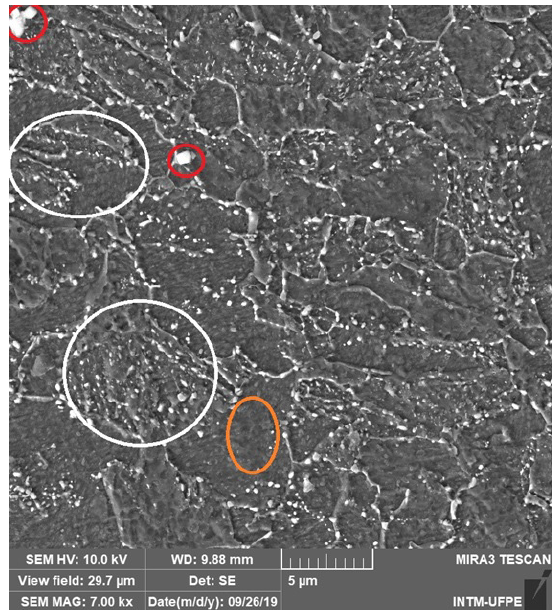
Figure 8. Microstructure of the material produced by the 680-15